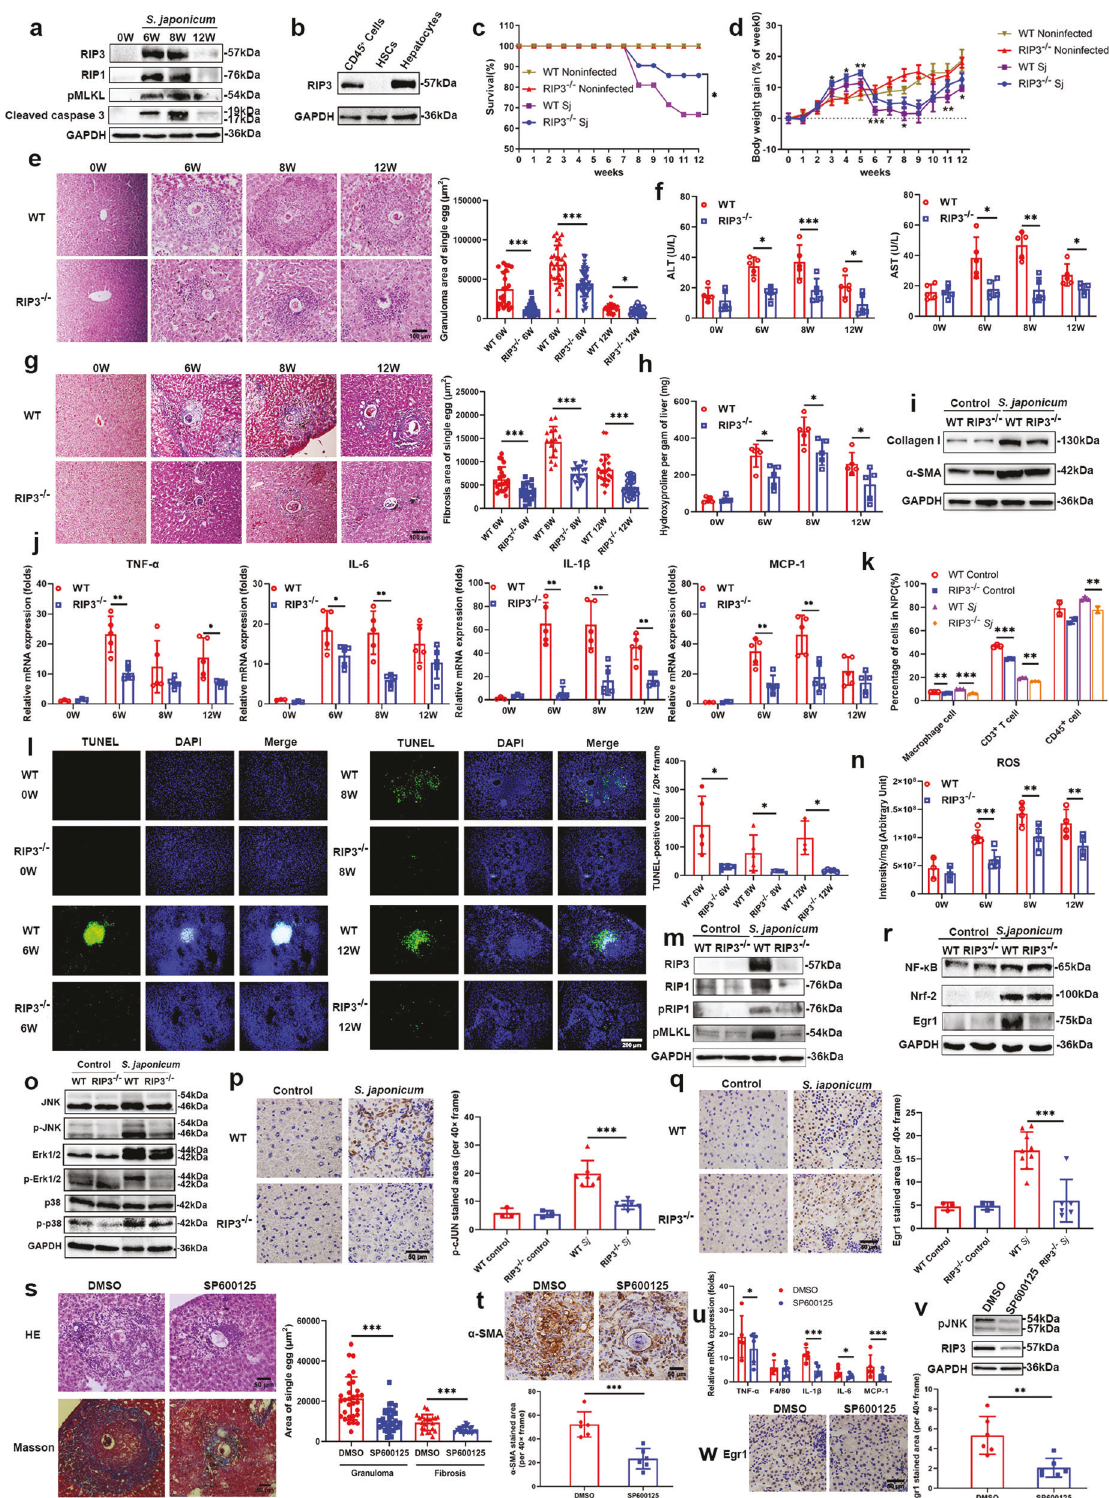
and the ROS level (Supplementary Fig. S7d). In addition, the JNK inhibitor also downregulated RIP3 expression (Fig. 1v), further con fi rming that RIP3 – JNK was positively feedback regulated. JNK inhibitors also downregulated the expression of Egr1 (Fig. 1w), which suggested that Egr1 was a downstream transcription factor